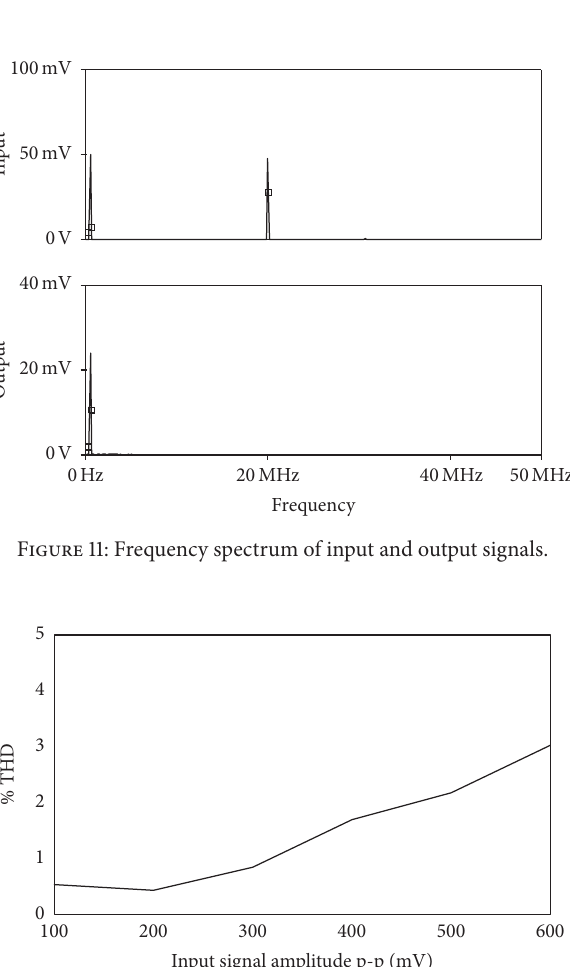
Figure9:Electronictuningdemonstration.(a)Cut-offfrequencyvariationwithbiascurrent.(b)Frequencyresponseforvariousbiascurrents.